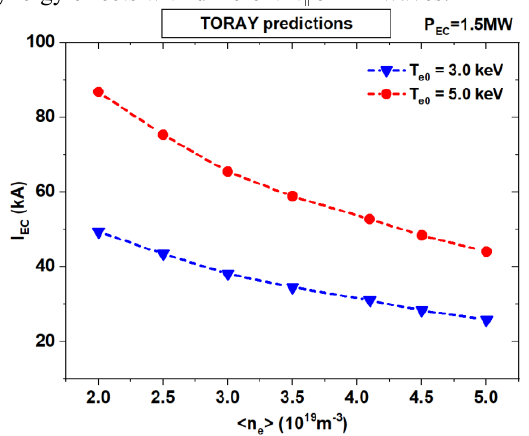
Fig. 14. Predicted ECCD current with different electron temperature and